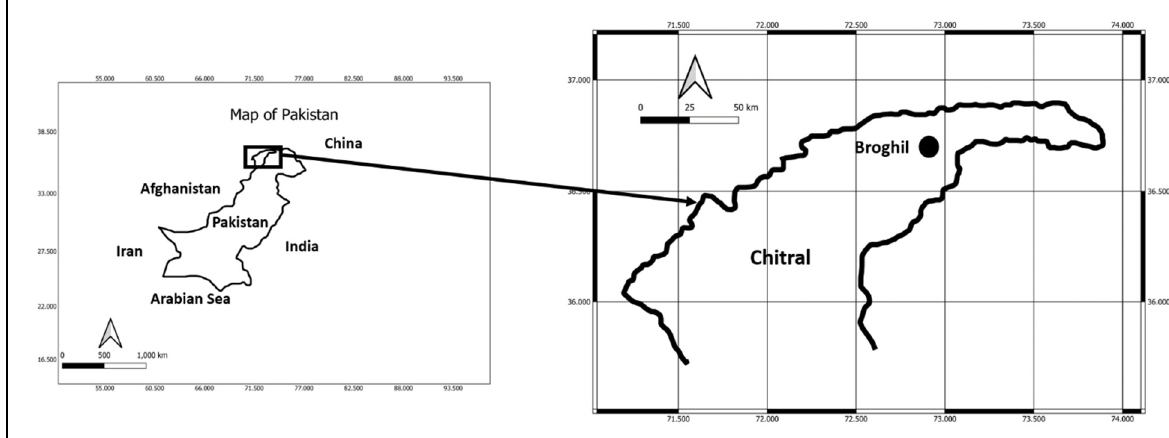
Figure 1. Map of the study area.